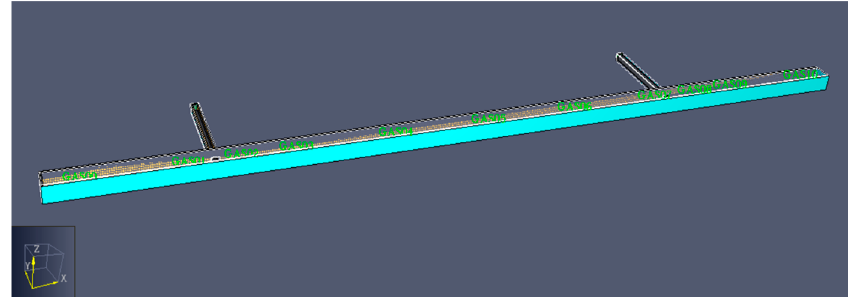
Figure 2. Simpli fi ed model diagram of underground interchange in Pyrosim software. Figure 2. Simplified model diagram of underground interchange in Pyrosim